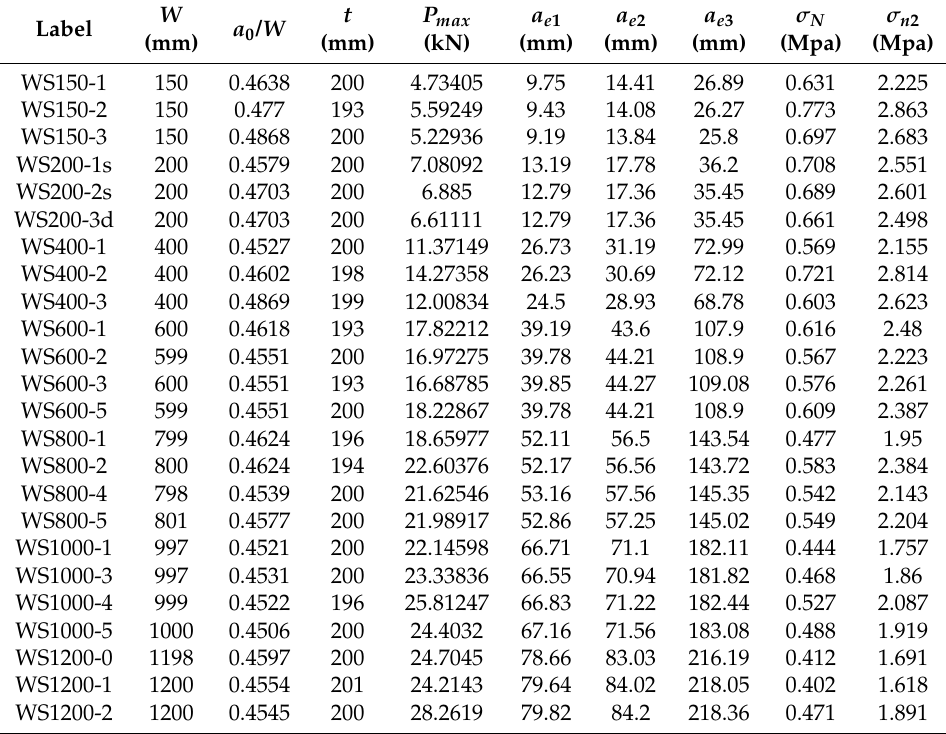
Table 1. Geometry, test results and equivalent crack length of wedge-splitting specimens